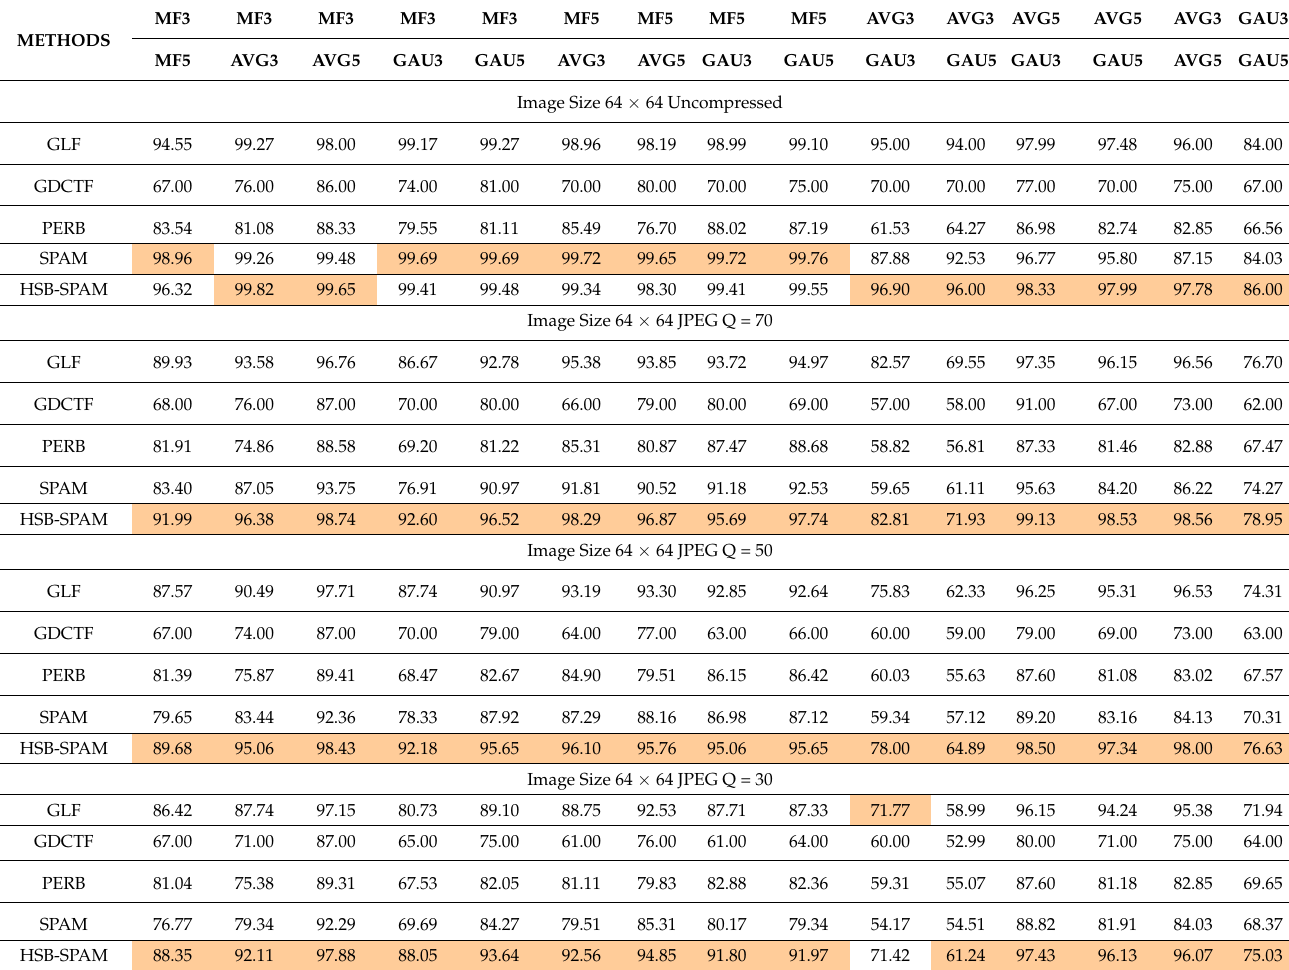
Table 5. Percentage of detection accuracy on filtered